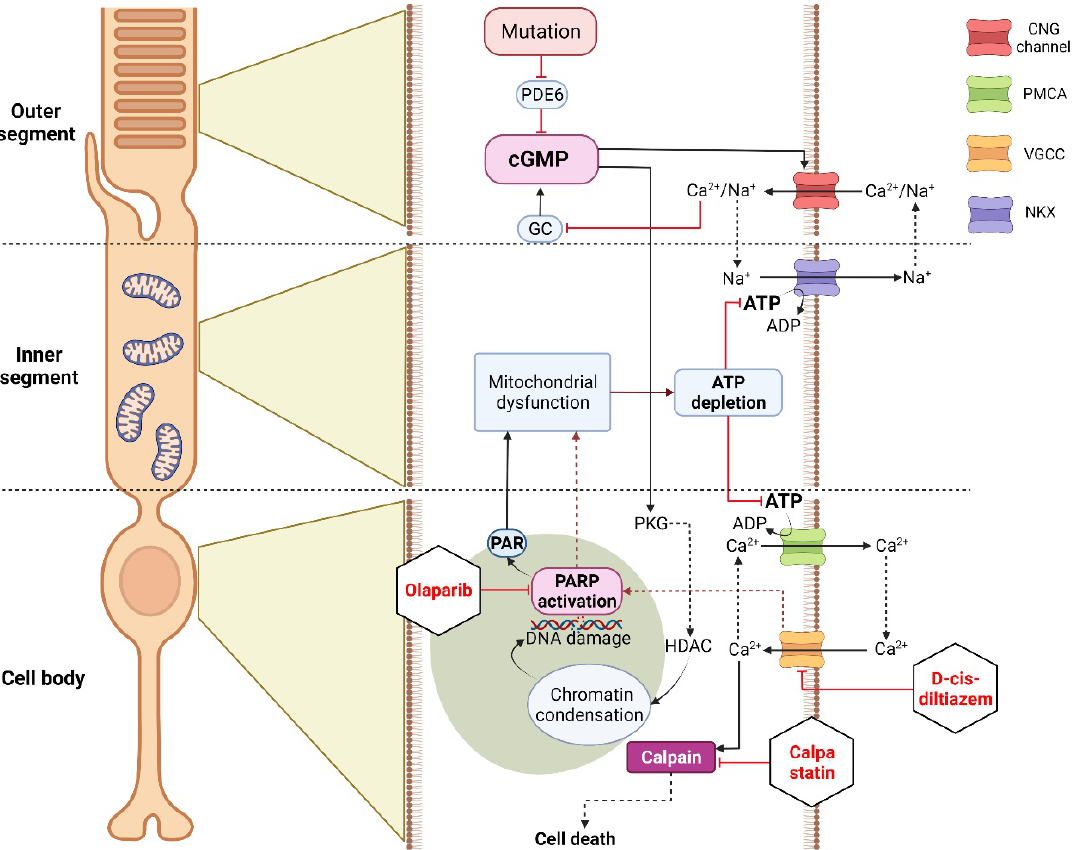
Figure 7. Differential effects of experimental conditions on cGMP-dependent cell death in rd1 photoreceptors. The mutation-induced cGMP accumulation activates cyclic nucleotide-gated (CNG) channels in the outer segment, leading to Na + -and Ca 2+ -influx and photoreceptor depolarization. This leads to opening of voltage-gated Ca 2+ -channels (VGCCs) in the cell body, causing further Ca 2+ -influx. In the cell body, high Ca 2+ levels may activate calpain if not controlled by ATP-dependent plasma membrane Ca 2+ -ATPase (PMCA). In addition, cGMP-dependent activation of protein kinase G (PKG) has been associated with histone-deacetylase (HDAC) activity, causing chromatin conden- sation and DNA breaks, which may trigger PARP activation. Excessive consumption of NAD + by PARP and the production of PAR may cause mitochondrial dysfunction, leading to ATP shortage. Calpastatin treatment blocks calpain activation, decreasing proteolytic damage to the cell, even in the presence of CNG channel/VGCC-mediated Ca 2+ -influx. D-cis-diltiazem inhibits VGCCs in the cell body, reducing intracellular Ca 2+ -levels and calpain activity. Moreover, VGCCs could be in- volved in PARP activation, even though D-cis-diltiazem fails to delay rd1 rod degeneration. Olaparib blocks PARP activity, decreasing NAD + consumption and PAR generation. This may pre- serve mitochondrial function and intracellular ATP levels, allowing PMCA to extrude Ca 2+ and keep- ing calpain activity low. 5. Conclusions In IRDs, the activities of calpain and PARP are both closely associated with photore- ceptor degeneration, and PARP is a known target for calpain-dependent cleavage. How- ever, here, we demonstrate that, in cGMP-induced photoreceptor degeneration, PARP regulates calpain activity, likely in an indirect fashion, via NAD + /ATP depletion or PAR- induced mitochondrial dysfunction. In addition, PARP activity is likely to be controlled by the activities of the VGCC and CNG channels. Overall, these results suggest PARP as a particularly attractive target for future therapeutic interventions in IRDs. The availabil- ity of a number of clinically tested PARP inhibitors [81,82] further enhances the perspec- tives for clinical translation. Author Contributions: Conceptualization, F.P.-D. and K.J.; formal analysis, J.Y., A.G. and S.D.; in- vestigation, J.Y.; resources, F.P.-D., R.M., S.M. and M.W.S.; data curation, J.Y.; writing—original